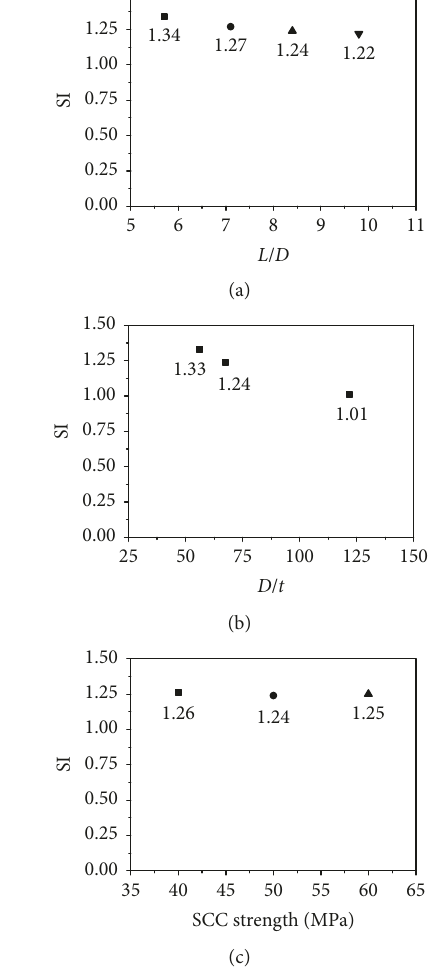
Figure 9: SI of specimens. (a) L / D ratio. (b) D / t ratio. (c) SCC